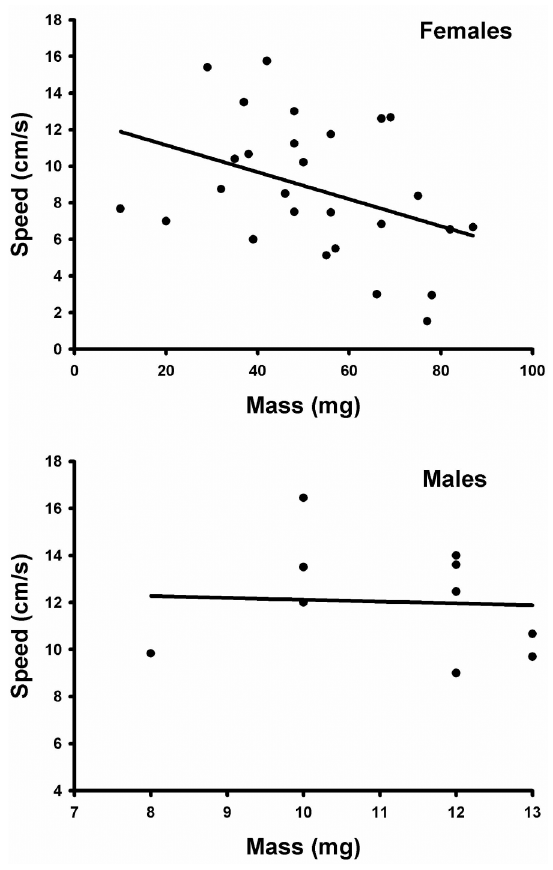
Fig. 1. Linear regressions between body mass and climbing speed in females (top) and males (bottom) of the spider Leucauge ve- nusta . The negative relationship for females is significant (p < 0.05; Speed = 12.7 – 0.07 × mass). The value for males comes close to signification if the outlier on the far left is removed (see text for statistical